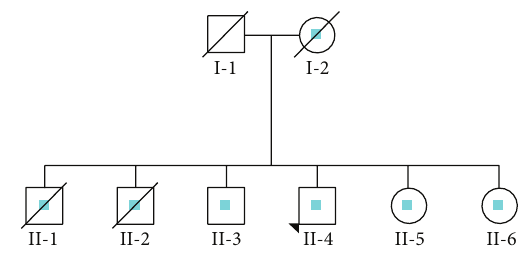
Figure 1: Pedigree of family with mitochondriopathy. I-1: death by suicide at 61; I-2: death from haemorragic stroke at 48; II-1: Leigh syndrome, death by suicide at 16 A; II-2: Leigh syndrome, death at 34 A, from respiratory failure; II-3: 34 A, epilepsy, cognitive impairment, and polyneuropathy; II-4: 33 A, index case; II-5: 17 A, cognitive impairment, ataxia, and peripheral neuropathy; II-6: 13 A, neurodevelopmental